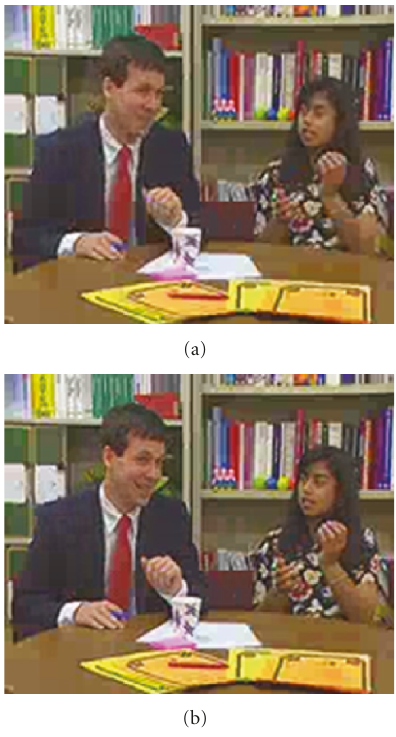
Figure 13: Visual comparison at t = 17 . 5 seconds (Paris, BLER = 10 . 8%, tti = 10 milliseconds). (a) No ROI di ff erentiation, (b) ROI and SNR combined scalability (“Paris” sequence).